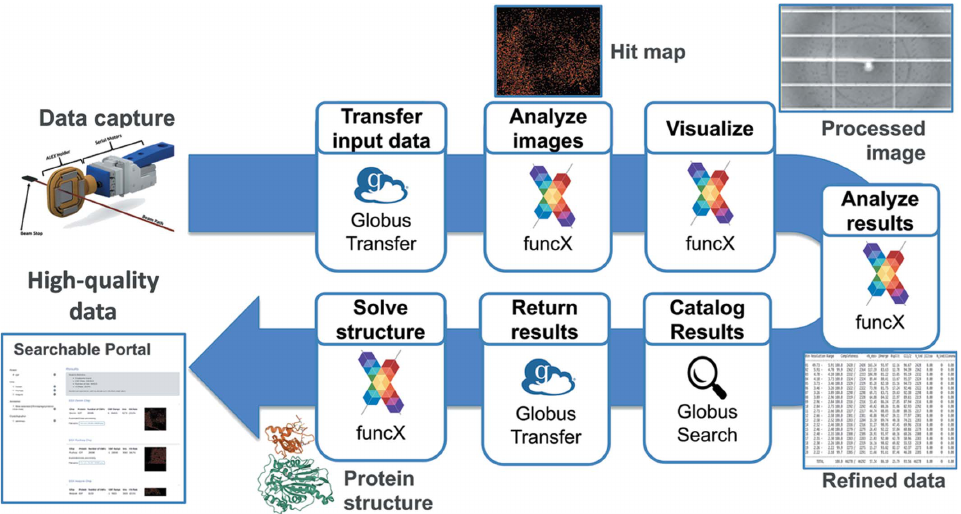
Figure 3 Data collection and processing pipeline. Data captured at 19ID trigger a Globus Flow to transfer images to Argonne Leadership Computing Facility where they are analyzed using the Theta supercomputer (Vescovi et al. , 2022). Results are visualized and published to a searchable data portal for